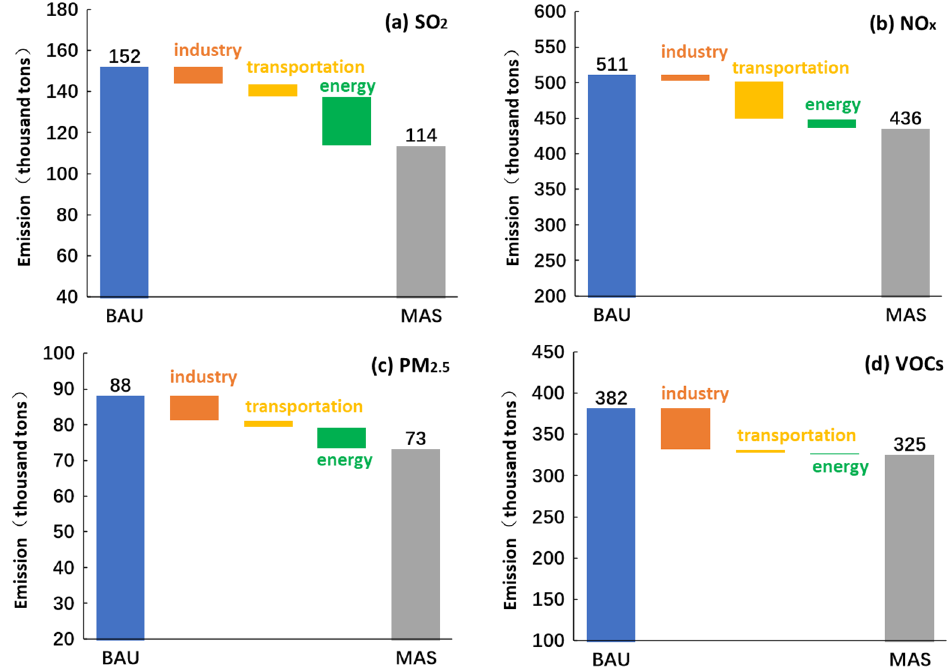
Figure 5. Contributions of different sector to pollutants’ emission reduction compared between BAU and MAS scenarios: ( a ) SO 2 , ( b ) NOx, ( c ) PM 2.5 , ( d ) VOCs.